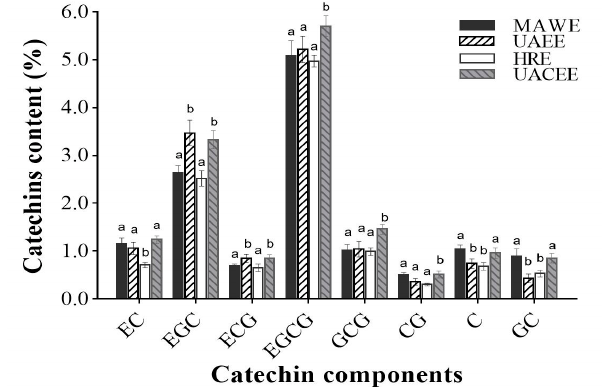
Fig. 4: Different extraction methods for catechin components content. MAWE, microwave-assisted water extraction; UAEE, ultrasonic- assisted ethanol extraction; HRE, heat reflux extraction; UACEE, ultrasound-assisted compound enzymatic extraction. different letters indicate statistically significant differences ( P < 0.05) between ex- traction methods and the same catechins. EC, (−)-epicatechin; EGC, (−)-epigallocatechin; ECG, (−)-epi- catechingallate; EGCG, (−)-epigallocatechin gallate; GCG, (−)-gallo- catechin gallate; CG, (−)-catechingallate; C, (+)-catechin; GC, (−)-gallocatechin.